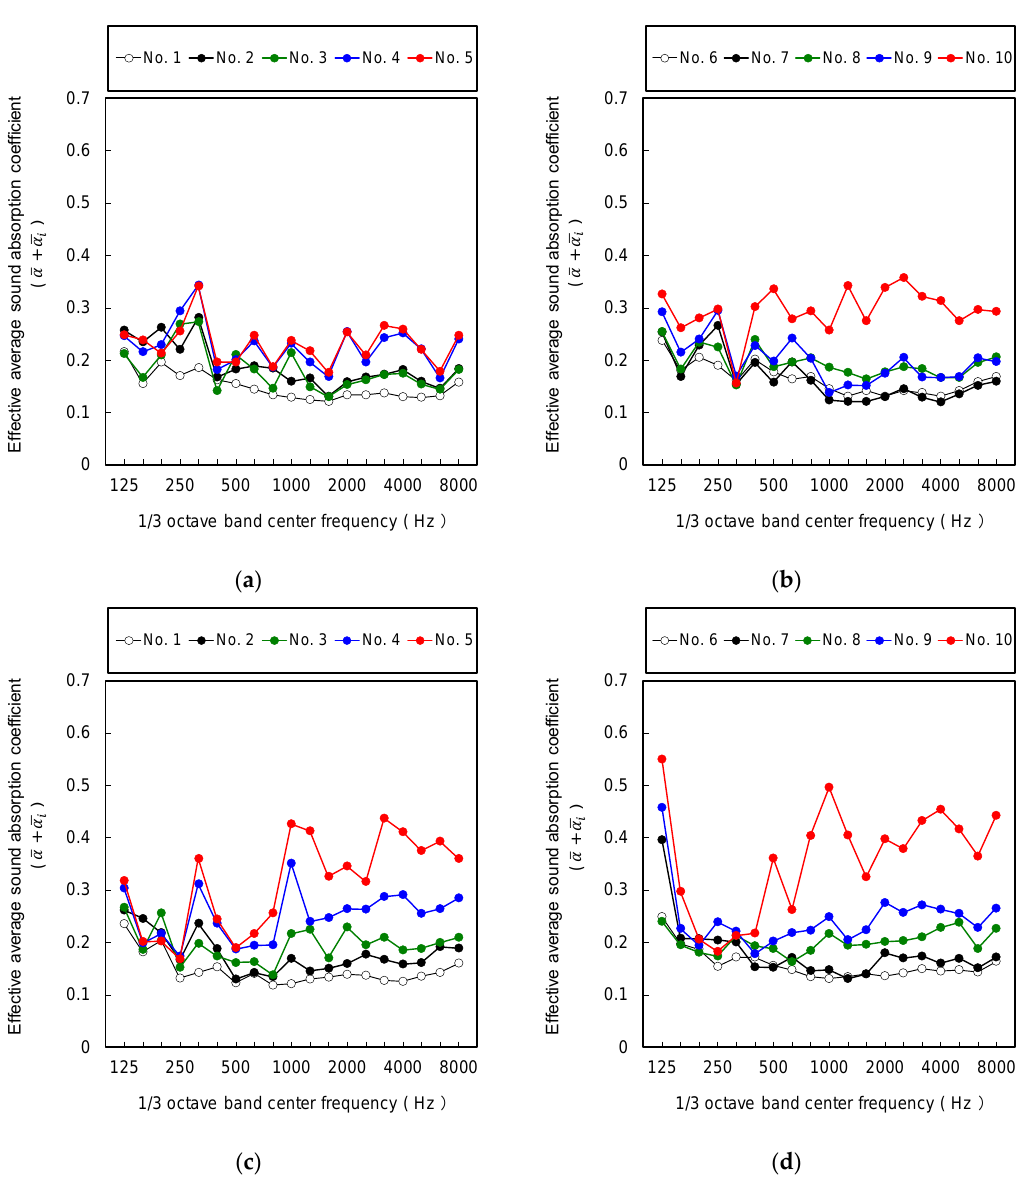
Figure 11. Effect on sound absorption coefficient of the sound absorption panel installation. ( a )